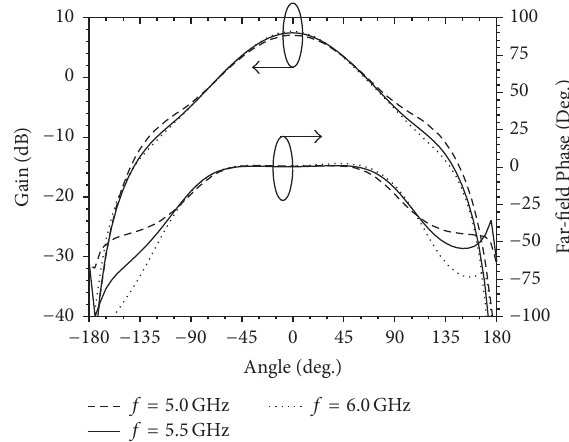
Figure 5: RHCP gain and phase patterns of the proposed feed on zx -plane.